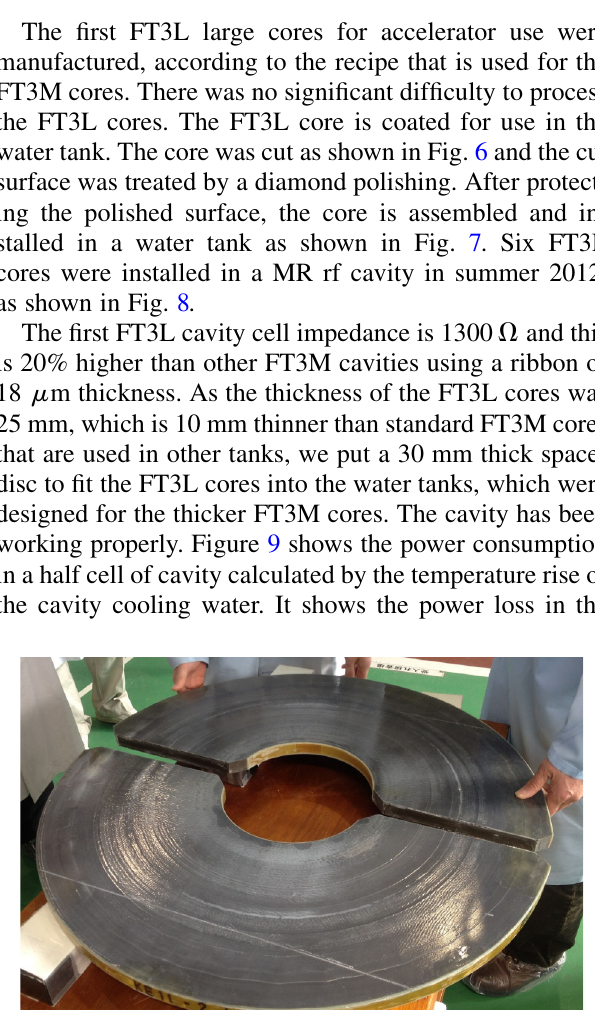
FIG. 4. The proof of principle system using a spectrometer magnet. An annealing oven is located between the magnet poles.